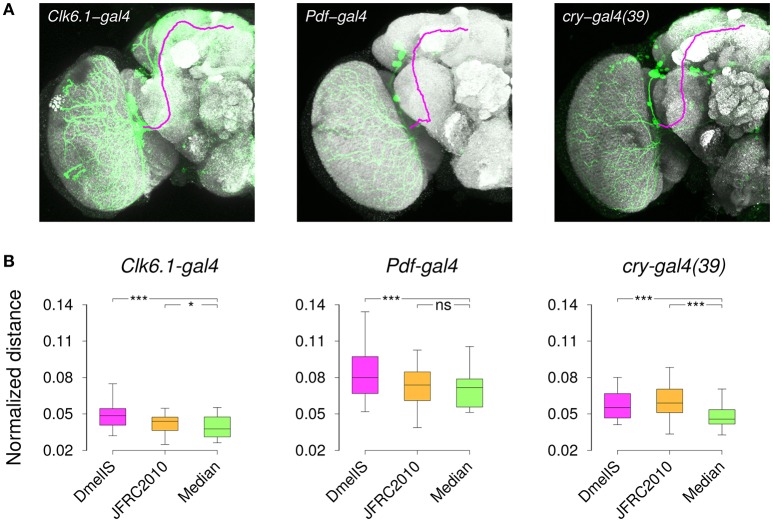
Registration of gene expression patterns. (A) Z-projections of individual 3D image stacks showing nc82-staining (Gray), transgene expression pattern (Green), and manually delineated 3D axonal traces (Magenta). (B) Distribution of the normalized distances between axonal projections after registering nc82-stained sample brains from Clk6.1-gal4, Pdf-gal4, or cry-gal4(39) transgenic lines. Registration was performed using either the FlyLight template (JFRC2010), the Jefferis' lab symmetric inter-sex template (DmelIS), or our median-intensity inter-sex template (Median). The results of the statistical comparison (paired Wilcoxon test) between the JFRC2010 or DmelIS templates with the Median template are indicated as: ns, P > 0.05, *, P < 0.01, and ***, P < 0.001.